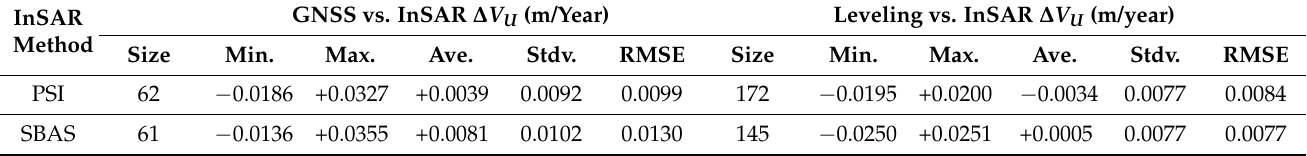
Table 2. Difference in vertical velocity ∆ V U estimated from the PSI and SBAS InSAR analyses with respect to that recorded with GNSS (permanent stations and benchmark surveying) and geodetic leveling. The size indicates the number of benchmarks used for comparison.